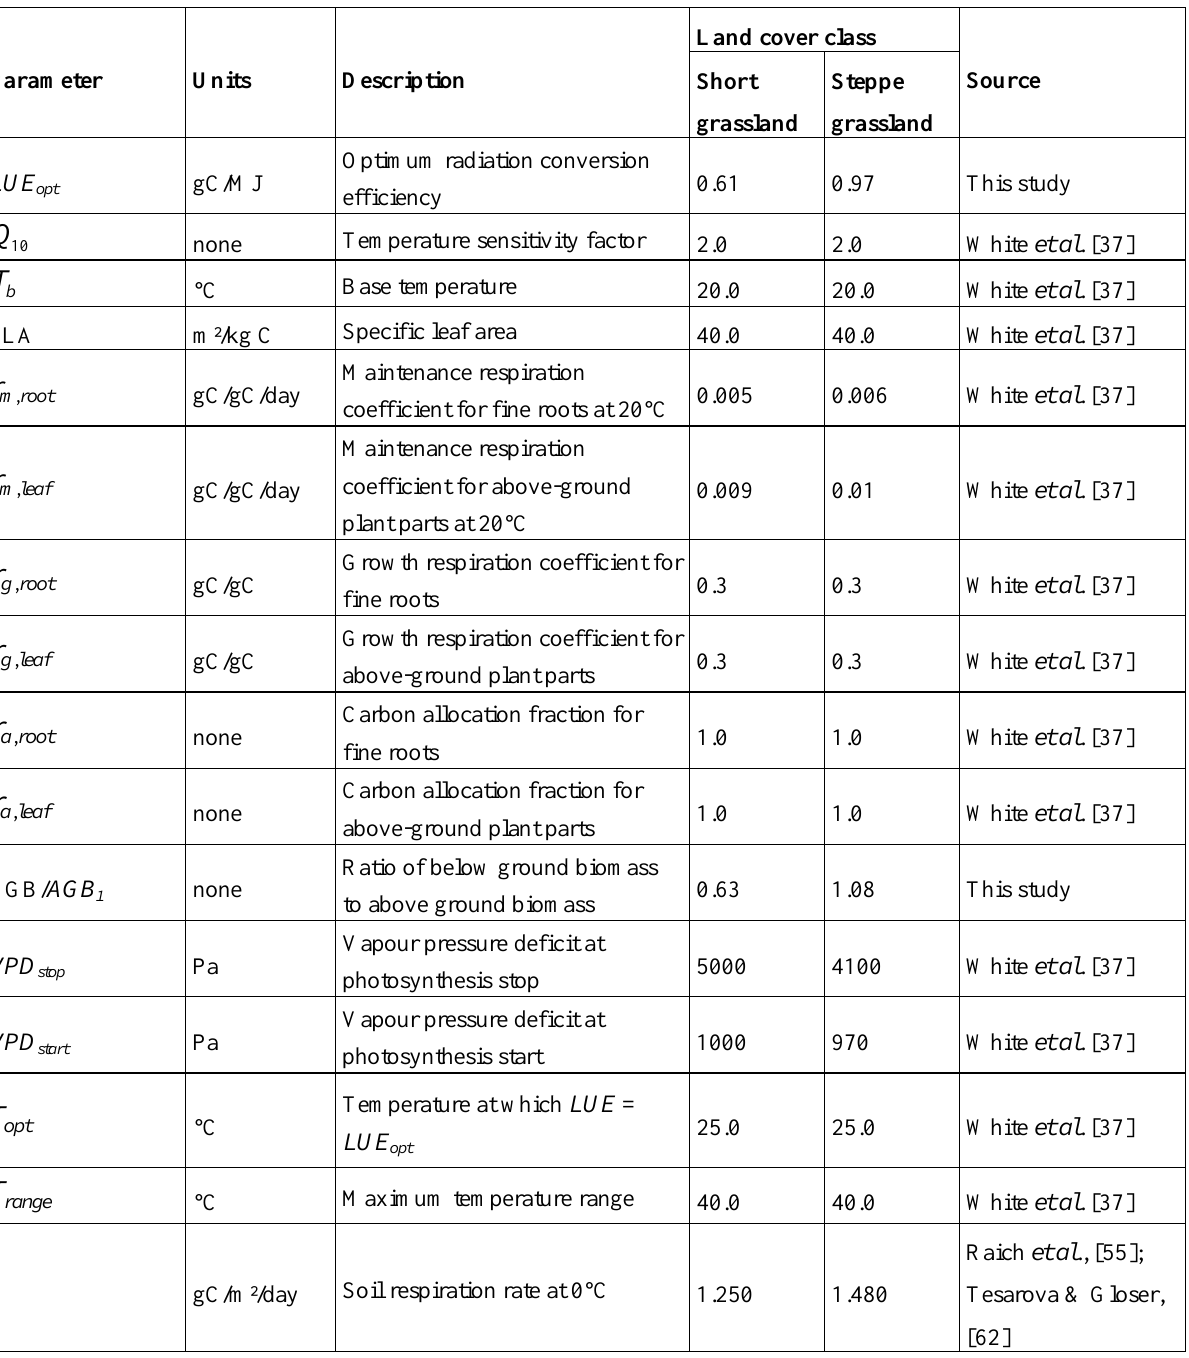
Table 2. The constant parameters, their descriptions, and values used for the light use efficiency model in this